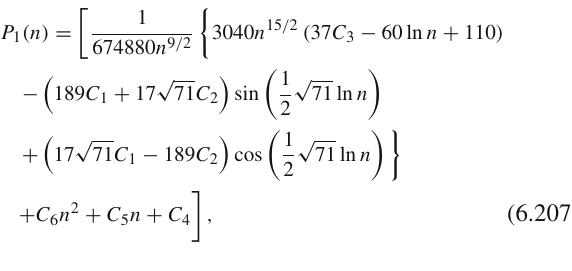
Here, in the large n limit the solution for P 1 ( n ) can